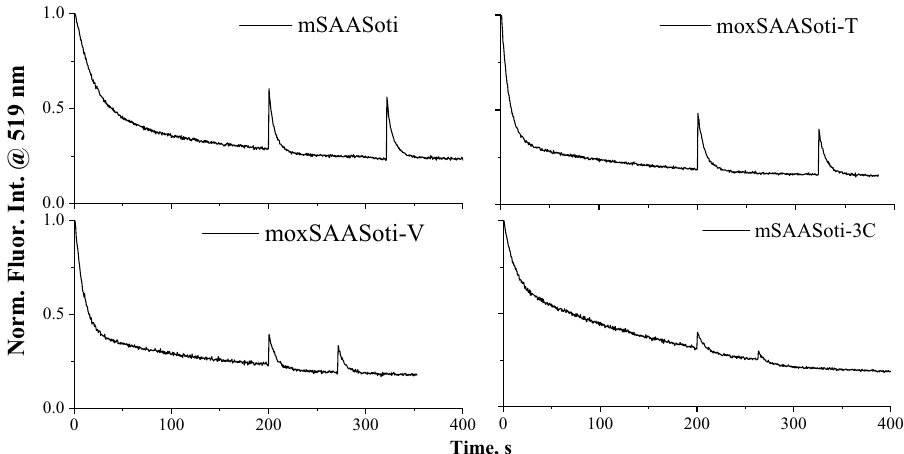
Figure 3. Normalized photoswitching profiles of mSAASoti variants. “Off” switching was induced by 470 nm illumination, “on” switching was induced by 400 nm illumination for 5 s. Proteins dissolved in 20 mM NaHCO 3 buffer, pH 9.2.